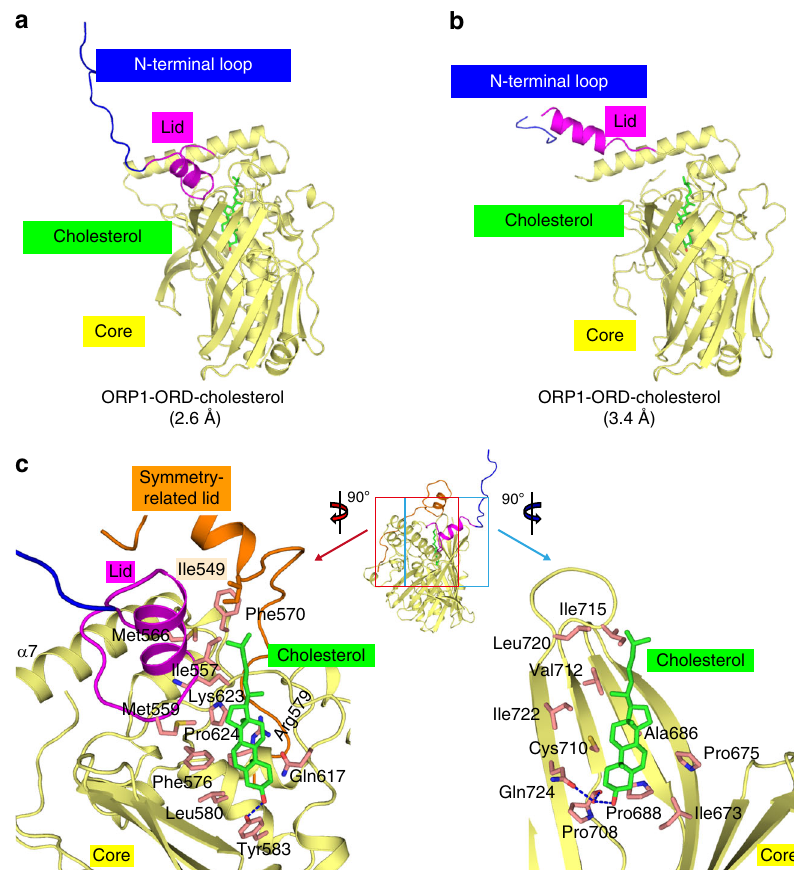
Fig. 4 Structures of cholesterol-bound ORP1-ORD in open conformations. a , b Overall structures of ORP1-ORD in complex with cholesterol at 2.6 Å ( a ) and at 3.4 Å ( b ). The cholesterol ligand is highlighted as green stick. c Detailed binding mode of cholesterol in the 2.6 Å structure. For clarity, part of the structure has been removed to show the ligand-binding tunnel. Dashed line, polar